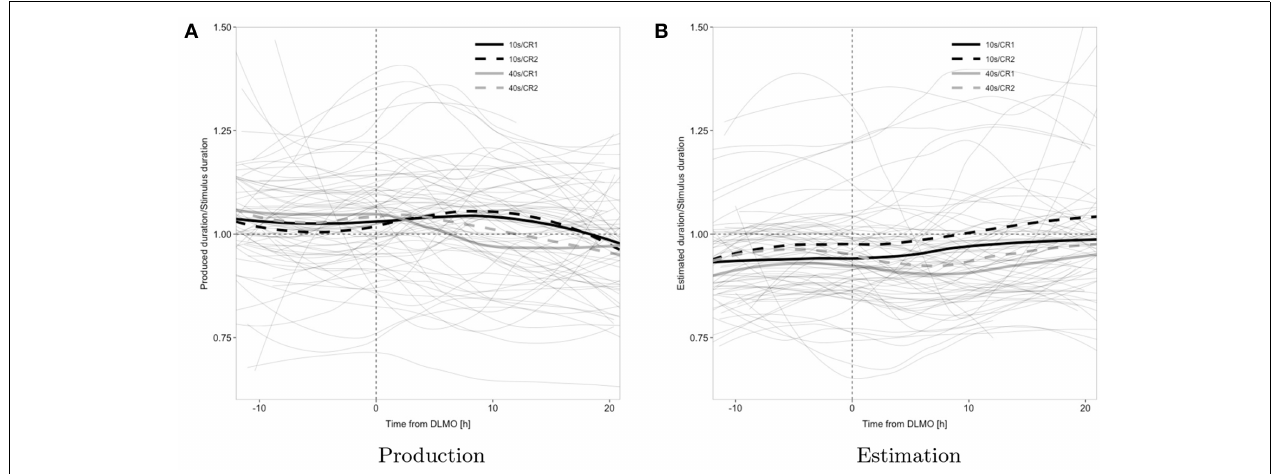
FIGURE 3 | Observed data; individual subject’s loess smoothed trajectories (thin solid gray lines; one trajectory per subject and condition) and average time course across all subjects by target